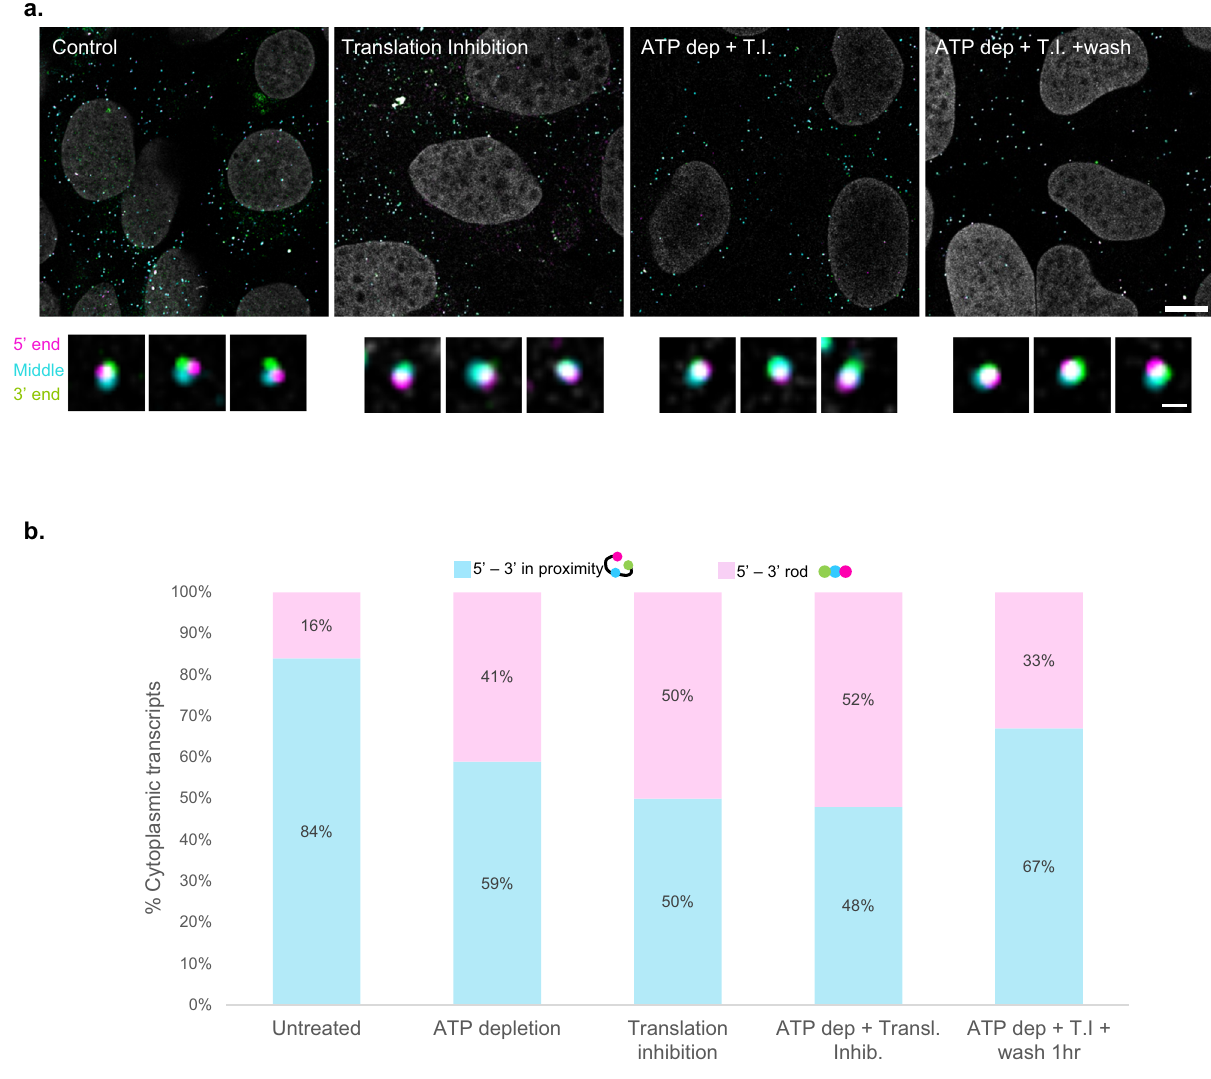
Fig.4|ATPlevelsandtranslationstateaffectmRNAcompactioninareversible manner. a MKI67 transcripts in U2OS cells, tagged in the 5 ’ (magenta), middle (cyan) and 3 ’ -end (green) of the transcript, along with images of single transcripts (enhanced). Scale bars, 10, 0.5 µ m. Adjustments to individual color channels were made. b Histograms depicting the percentages of the orientation between the 5 ’